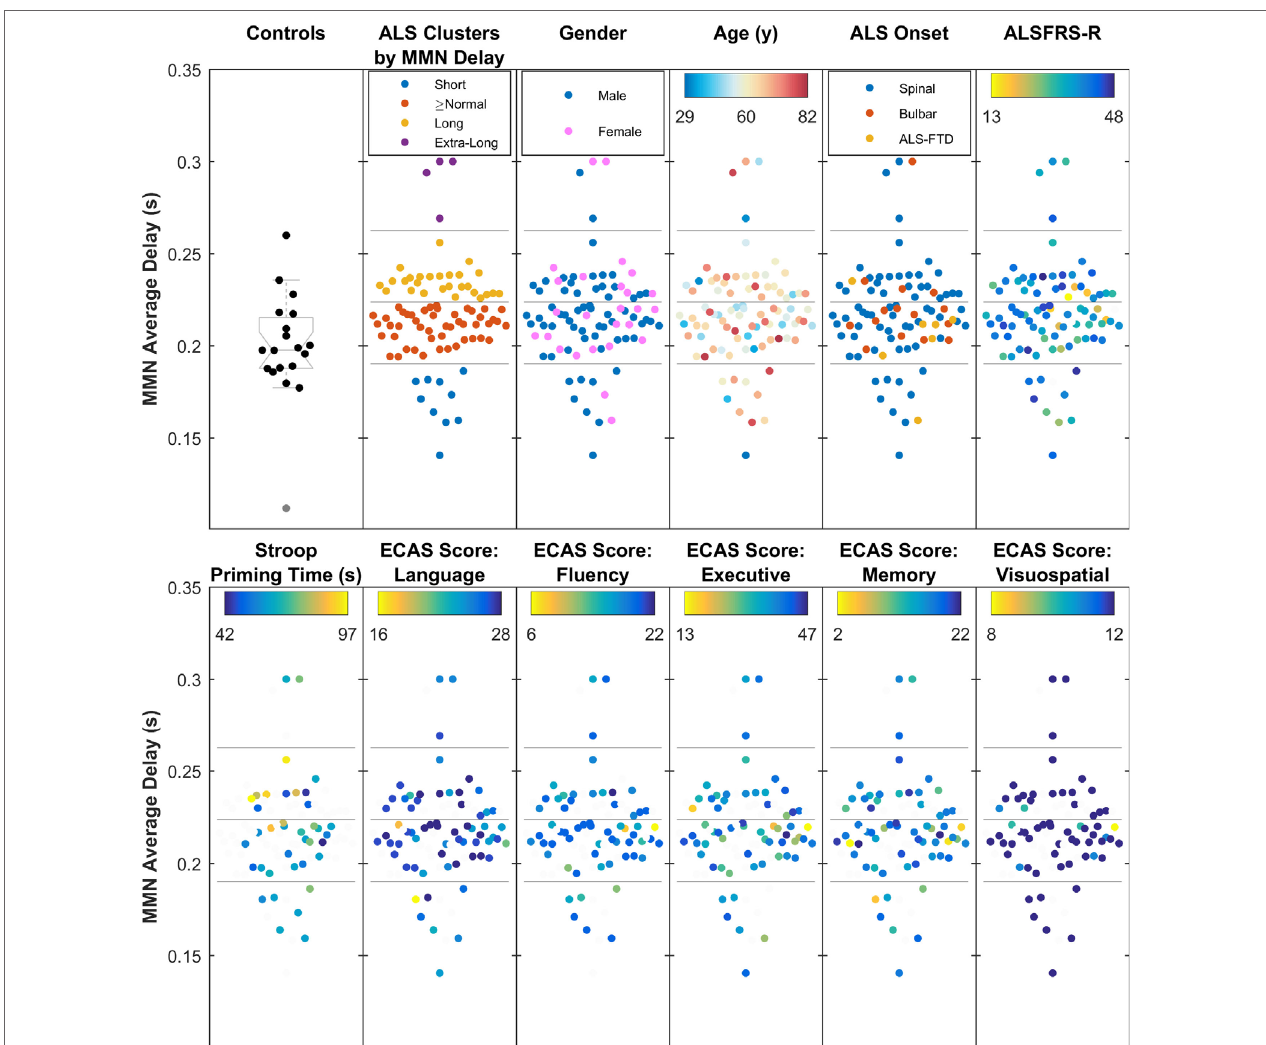
FigUre 7 | The four clusters of amyotrophic lateral sclerosis (ALS) patients, based on the average mismatch negativity (MMN) delay (short, above normal, long, and extra-long delays), showing moderate relationship with Stroop Color–Word Interference task (i.e., cognition), but no overlap with traditionally defined phenotypes, age, gender, ALS Functional Rating Scale (ALSFRS-R), or five main Edinburgh Cognitive and Behavioural ALS Screen (ECAS) scores. The four subgroups, found through k -mean clustering of the average MMN delay are shown against healthy